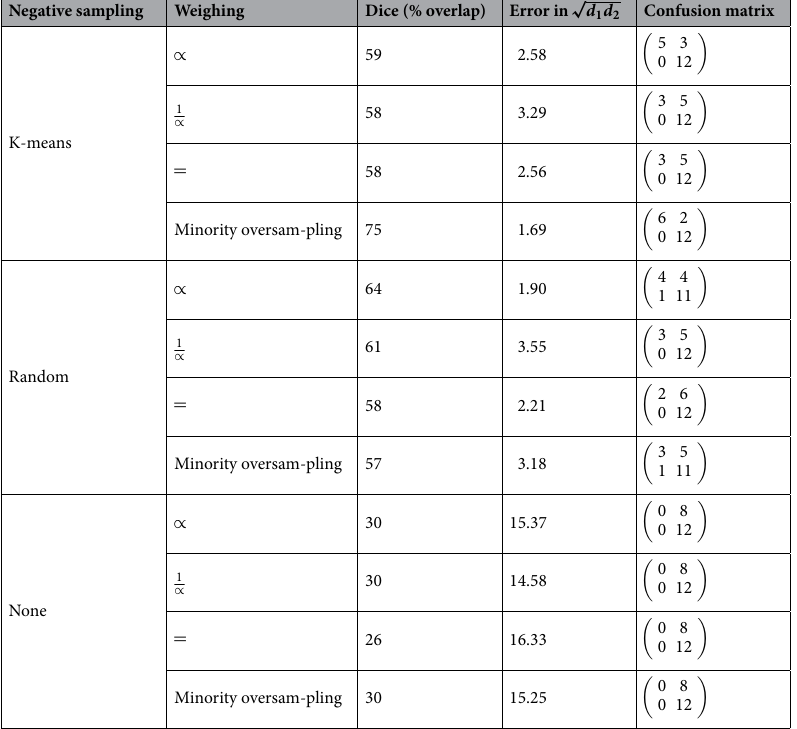
Table 3. The effect of sampling negative instances randomly versus a clustering approach. Under each sampling strategy, we compare various methods to handle class imbalance. ∝ indicates using class weights in cross-entropy loss directly proportional to class distributions, = uses weights 1 for all classes. Each setting uses the EfficientNet-B0 framework, 256 as the tile stride, and only random cropping as data augmentation.